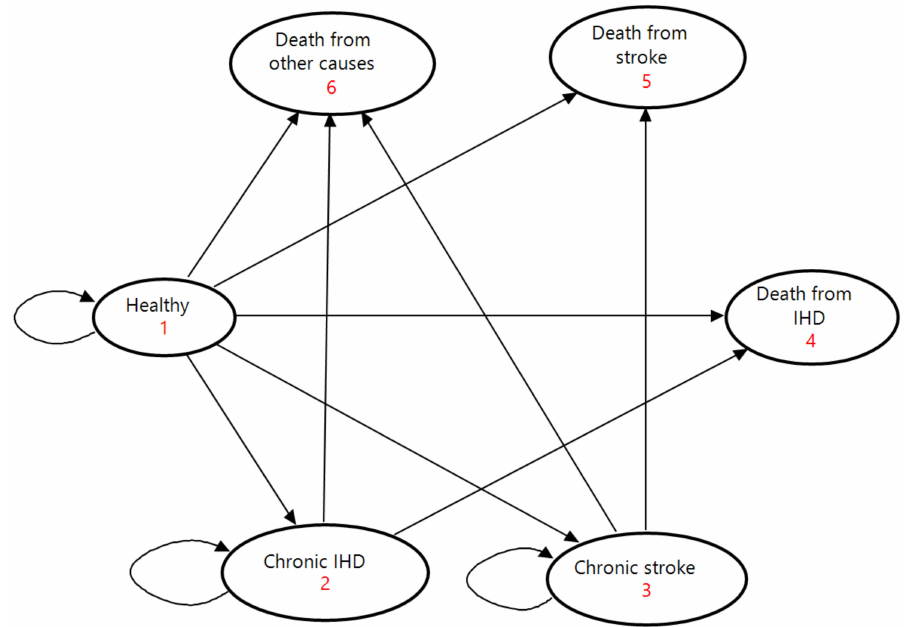
Figure 1. State-transition diagram of the Markov model. Ovals represent the six health states. Direct arrows represent directions of transitions of the cohort between health states. Circular arrows indicate the cohort remaining in each health state. Each arrow has a transition probability. IHD, ischemic heart